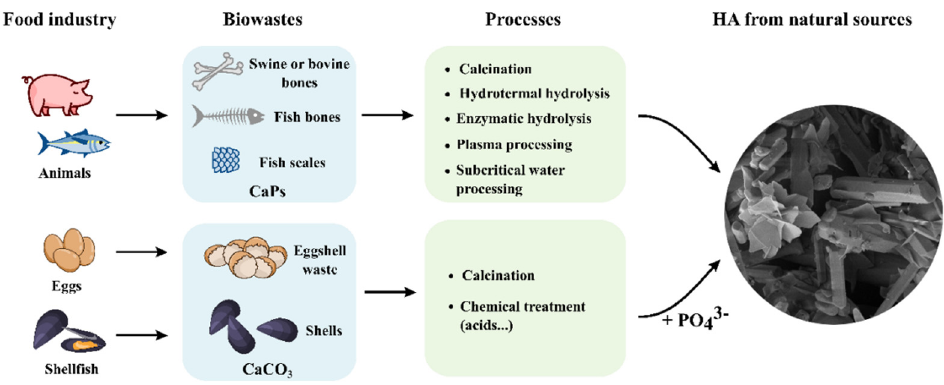
Figure 1. Scheme of the preparation of calcium phosphates from biogenic sources. Irrespective of the application, all the functions of CaPs are tightly related to their physicochemical characteristics, such as particle size, morphology, crystallinity, porosity, density, composition, Ca/P atomic ratio, or pH stability range, and all these characteristics can be tailored by modifying the CaP synthesis (Figure 2) [26,46,47]. In addition, different CaP crystal phases can be prepared, which in turn have different morphologies, chemical compositions, or structures [26,46,47]. In this section, the main proprieties of the four more relevant CaP phases for cosmetic applications will be